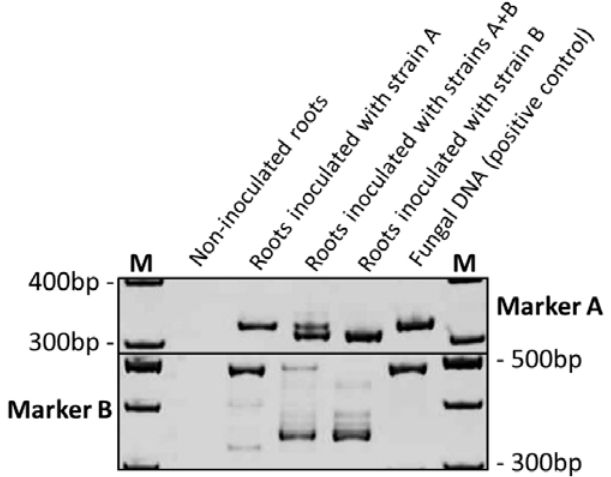
Figure 4. 5% PAA gel with samples from single and double root